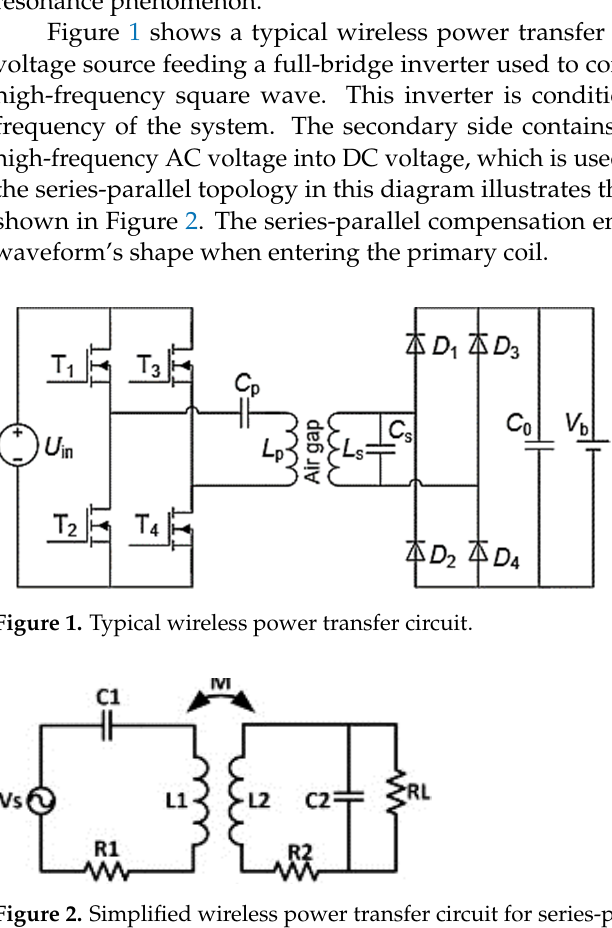
Figure 2. Simplified wireless power transfer circuit for series-parallel configuration.